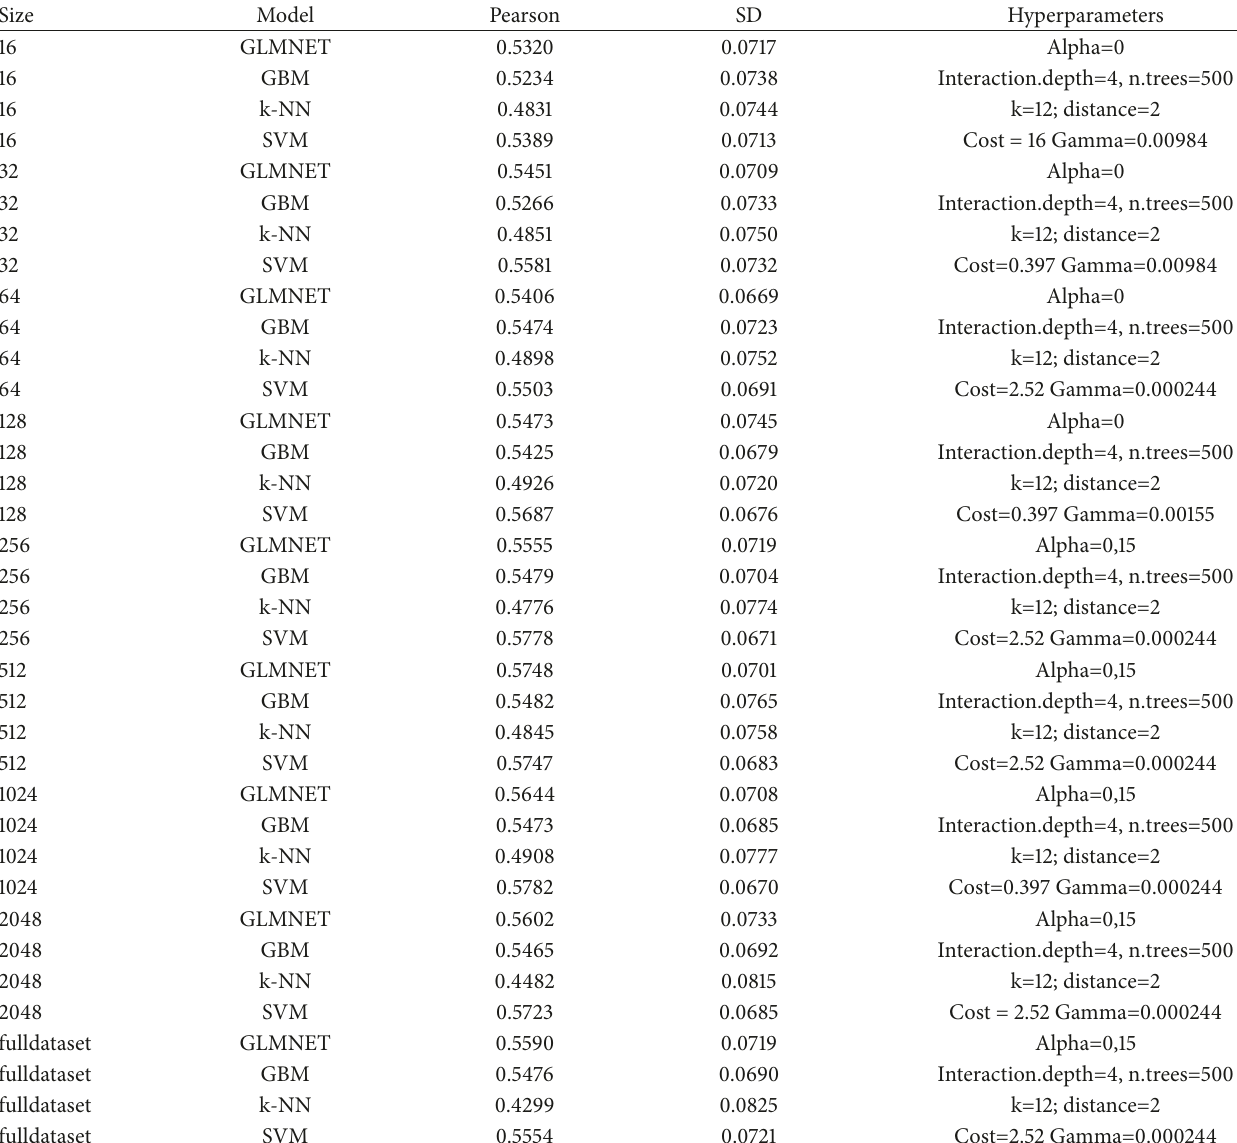
Table 2: Average results presented in Figure 5, identifying hyperparameters and input size for each